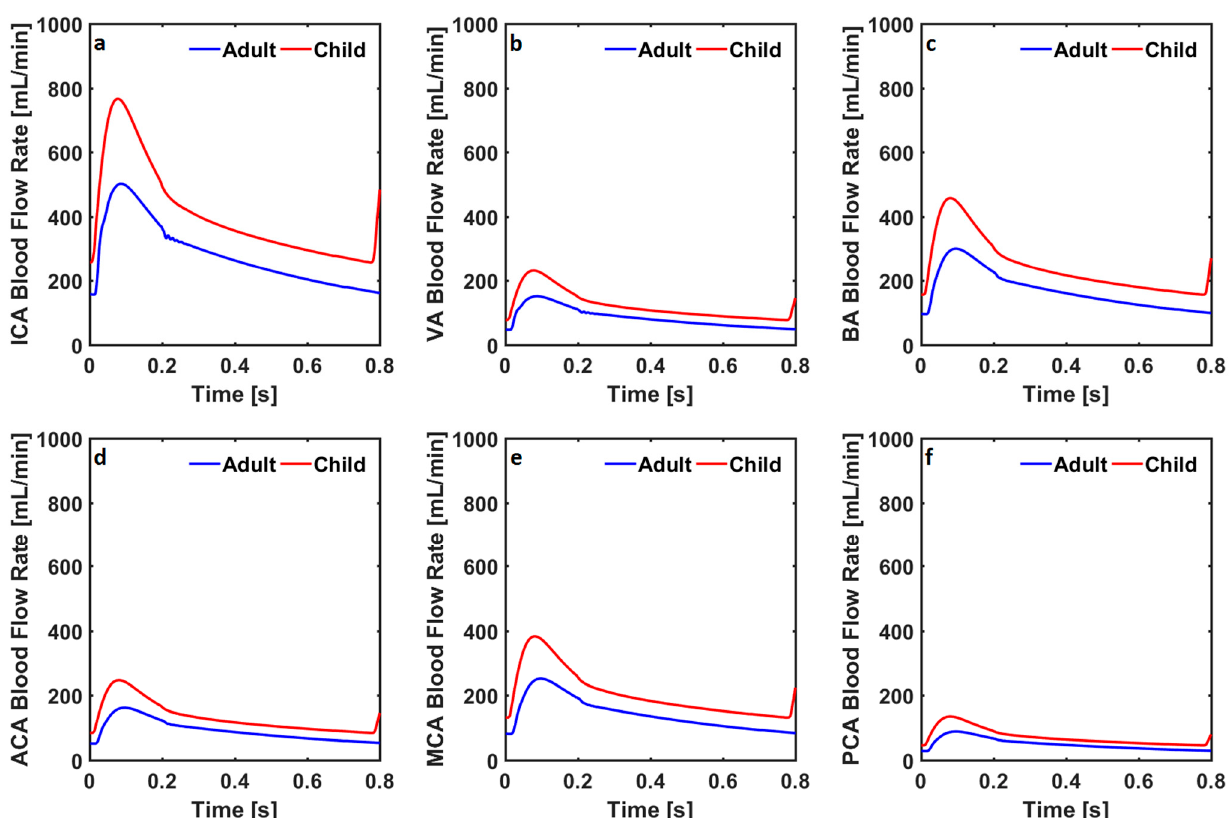
Figure 3. Blood flow rates through ( a ) the internal carotid arteries (ICA), ( b ) the vertebral arteries (VA), ( c ) the basilar artery (BA), ( d ) the anterior cerebral arteries (ACA), ( e ) the middle cerebral arteries (MCA), and ( f ) the posterior cerebral arteries (PCA) in the numerical model simulating healthy conditions in adults and children.